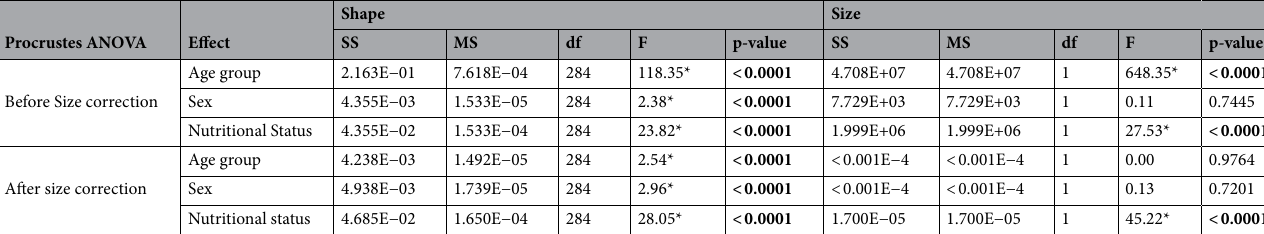
Table 1. Ontogenetic, sexual and nutritional effects on children body shape and size. Procrustes ANOVA test for shape (Procrustes coordinates) and size (log centroid size) in the whole sample by means of age groups, sex, and nutritional status. Procrustes sums of squares (SS). Procrustes mean squares (MS). degrees of freedom (df). Goodall’s F statistic (F). (*) Significance level: p <